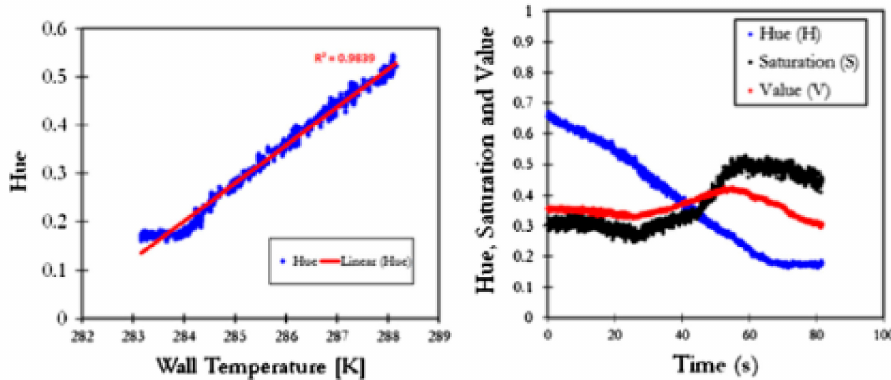
Figure 6. Hue, saturation, intensity calibration from Singh and Ekkad [12]. Reprint with permission from Elsevier (order number